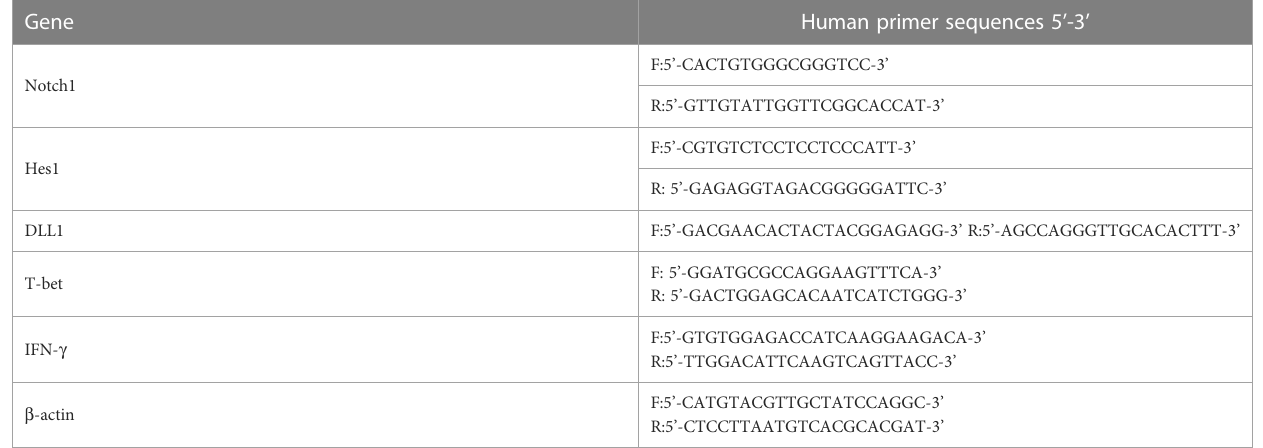
TABLE 1 Human primer sequences used in real- time